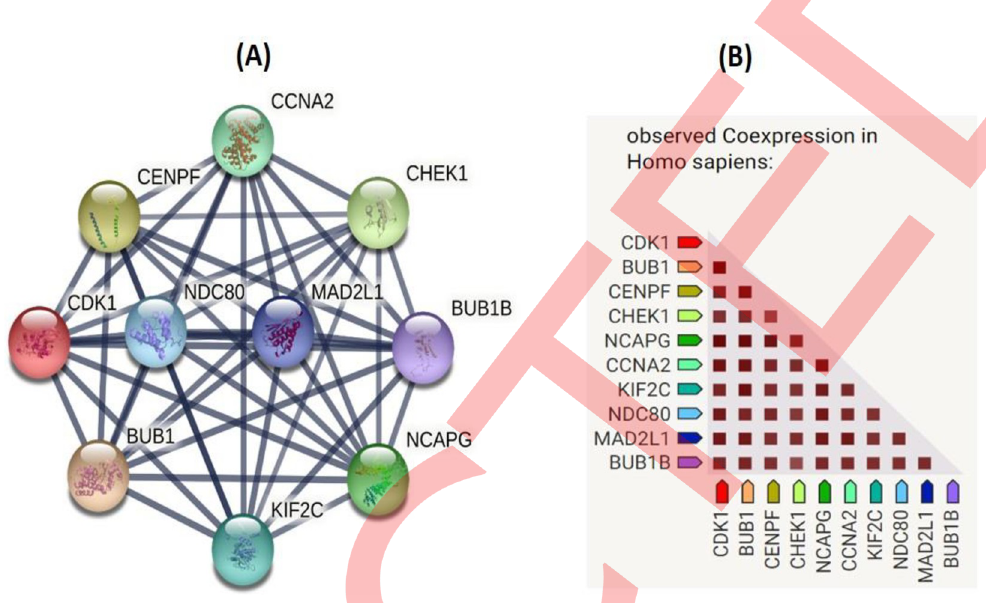
Fig 4. (A) Construction of PPI network of 6 hub genes (B) Observed coexpression of 10 hub genes in Homo